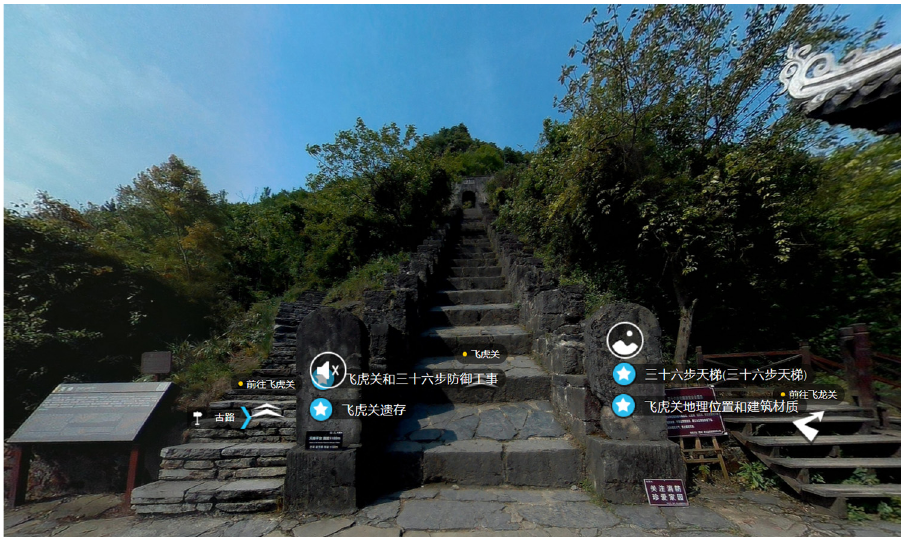
Figure 4: System interface based on panoramic images.